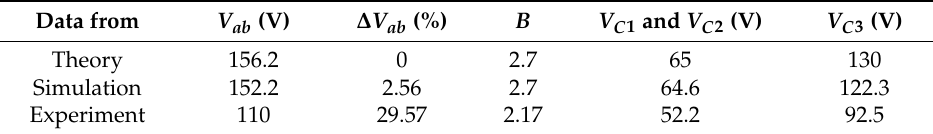
Table 4. Comparison between Calculated, Simulated and Experimental Values.